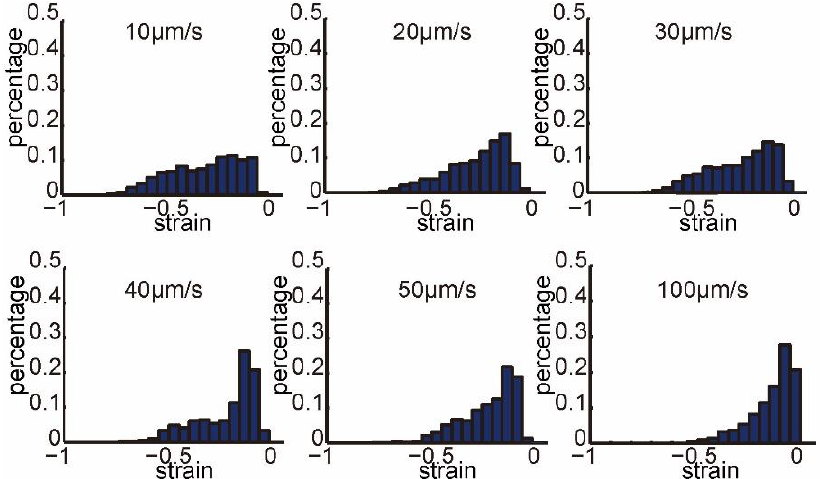
Figure 4. Normalized histograms of the strain field on the last frame before oocyte penetrated at each penetration speed (penetration speed: 10, 20, 30, 40, 50, and 100 μm /s).